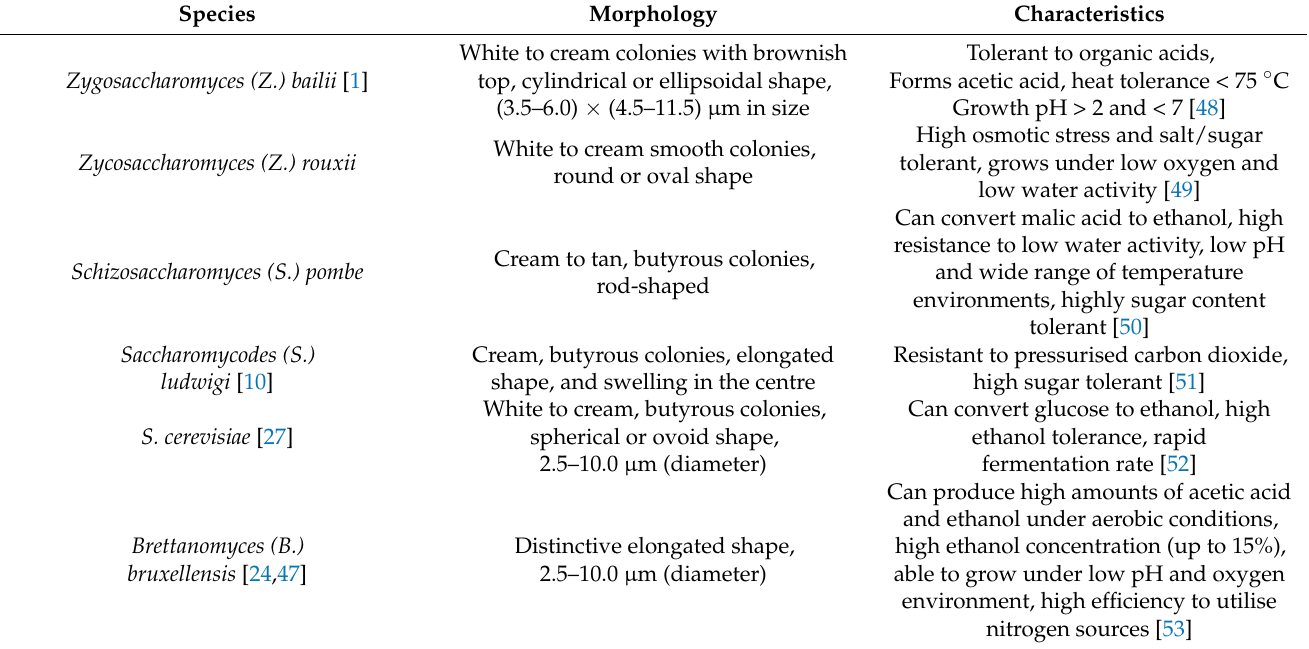
Table 3. Common yeast species isolated from Kombucha and their metabolic characteristics.